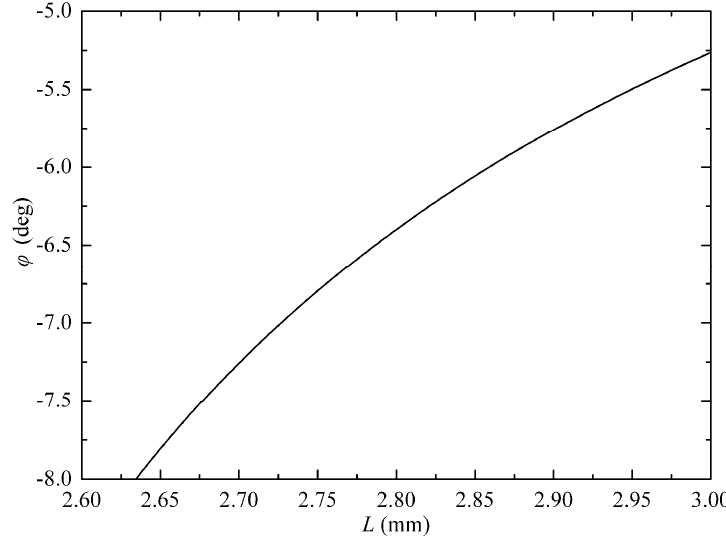
Figure 3. Correlation between the parameters of the collimating lens.